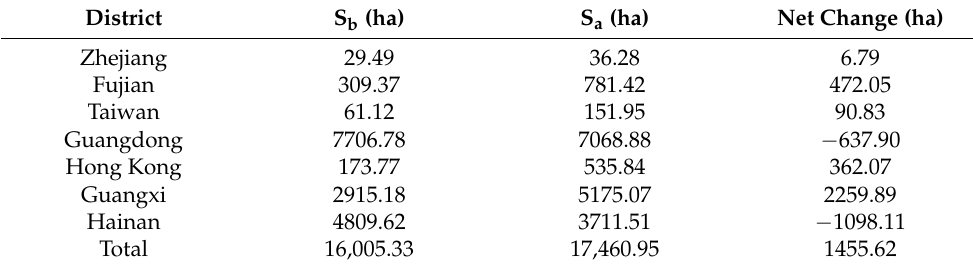
Table 7. Dynamic changes of mangrove area in the reserves of different districts before and after protection.